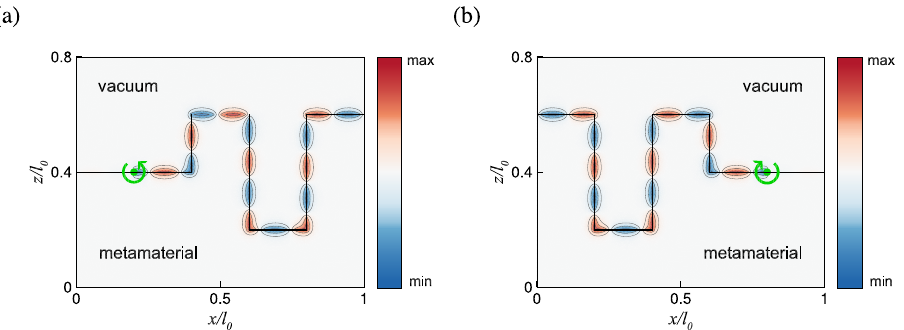
Figure 4. Surface wave propagation at the interface between vacuum and the pseudochiral metamaterial with ε = µ = 1.5 , γ = 2 , and k y / k 0 = 1.28 for ( a ) right-handed and ( b ) left-handed circular polarization, which correspond to the red and blue dots, respectively, in Fig. 2b. Green dot is the position of dipole source. Circular arrow denotes the handedness of circular polarization. Red and blue colors correspond to positive and negative values of Re[ E y ], respectively, and x and z coordinates are scaled by l 0 ≈ 12.43 (cid:31) 0 , with (cid:31) 0 = 2 π/ k 0